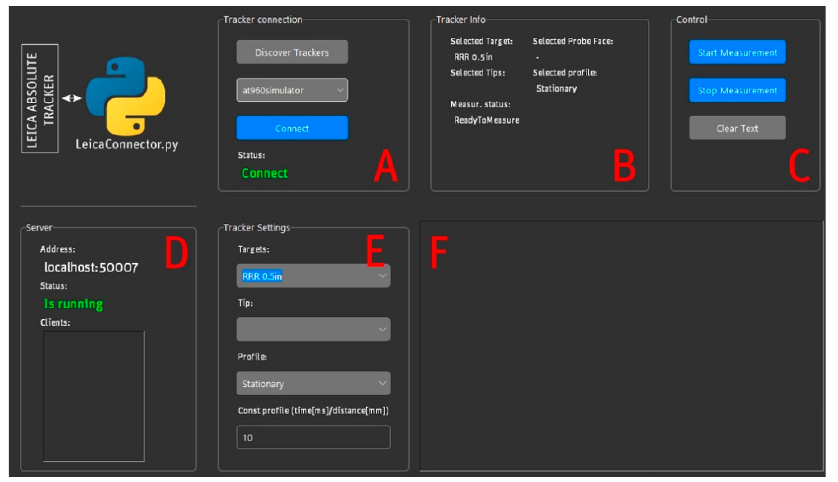
Figure 4. Program